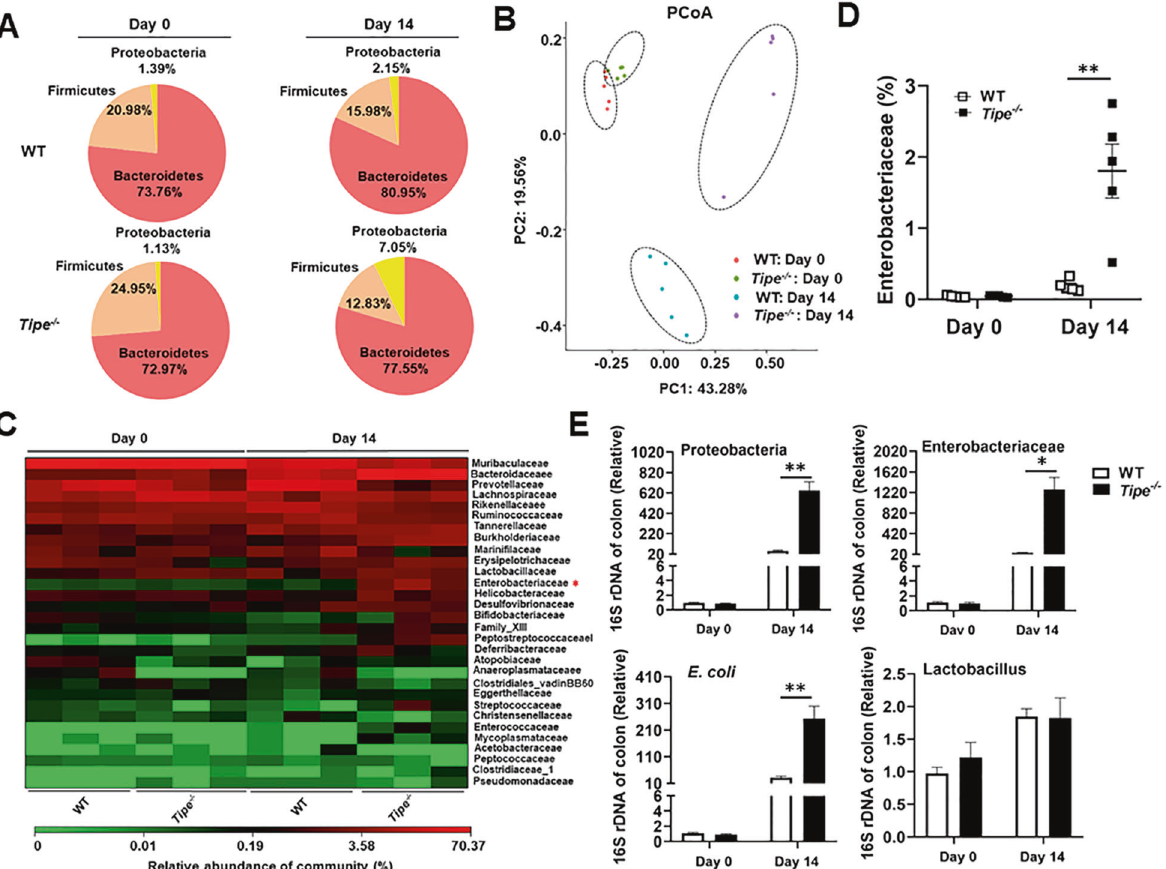
Fig. 3 TIPE de fi ciency accelerates in fl ammation-associated dysbiosis. A Comparison of fecal specimens bacterial communities from WT ( n = 5) and Tipe − / − ( n = 5) mice on day 0 or day 14 of the CAC model at the top 3 phylum level by 16S rRNA sequencing. B PCoA analysis